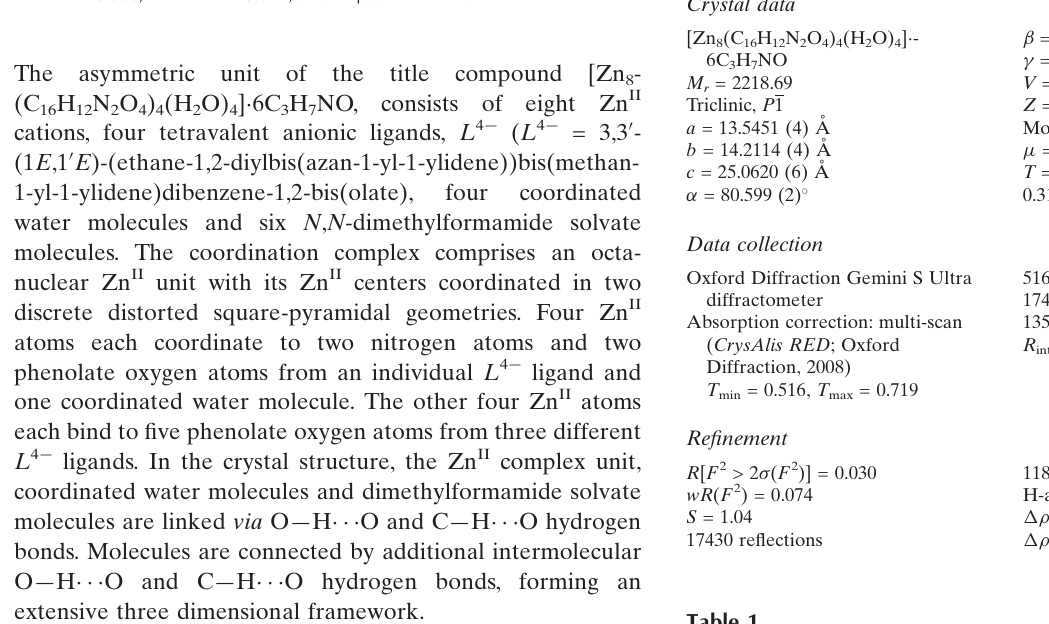
Hydrogen-bond geometry (A˚ , (cid:4) ). D —H (cid:2)(cid:2)(cid:2)